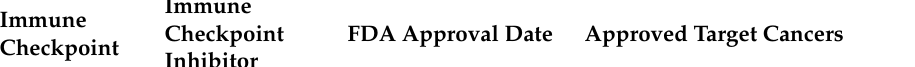
Table 1. Approved ICI therapies by the Federal Drug Administration